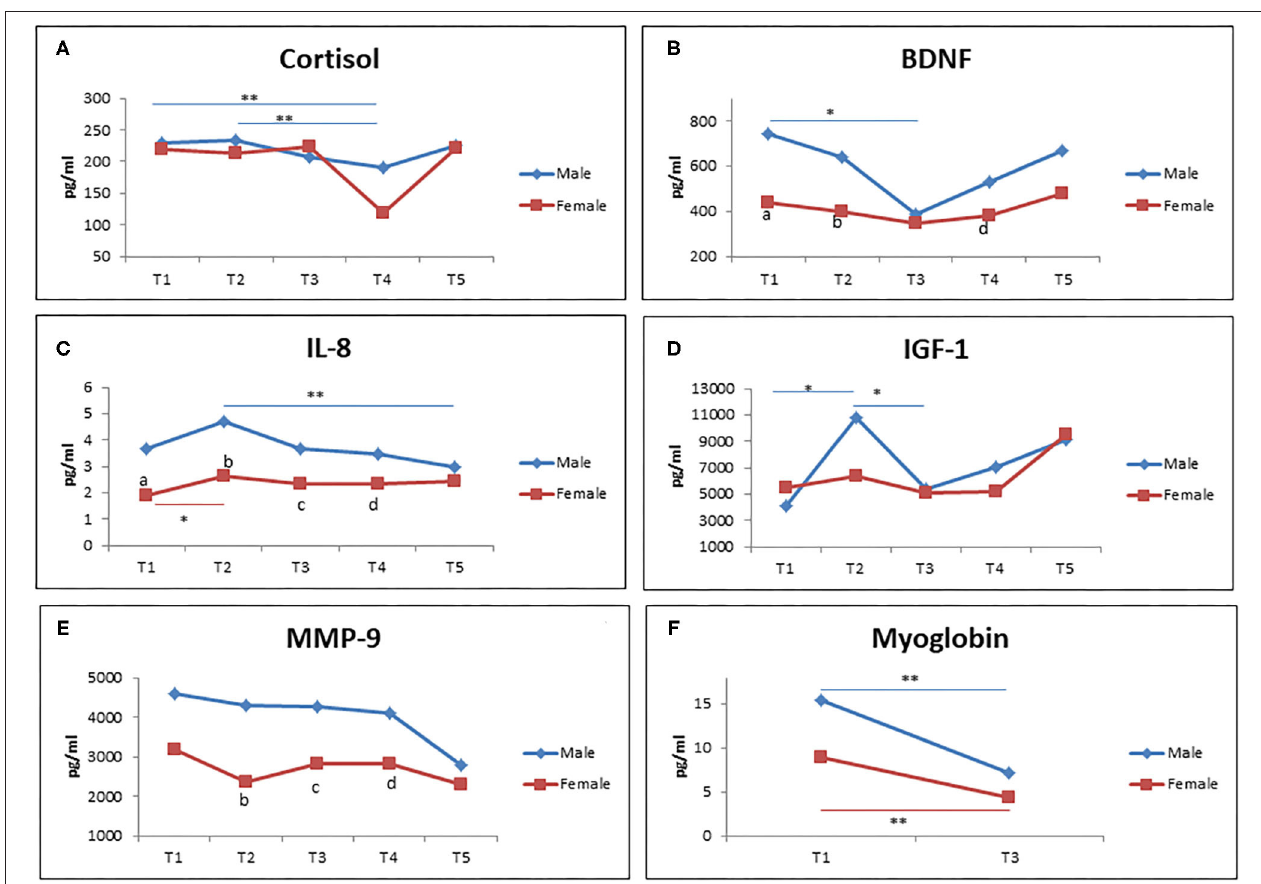
FIGURE 3 | The level of cortisol (A) , BDNF (B) , IL-8 (C) , IGF-1 (D) , MMP-9 (E) , and myoglobin (F) during RF (male = 19; female = 15). (a–e) significant difference between men and women at T1, T2, T3, T4, and T5. * p < 0.05, ** p <